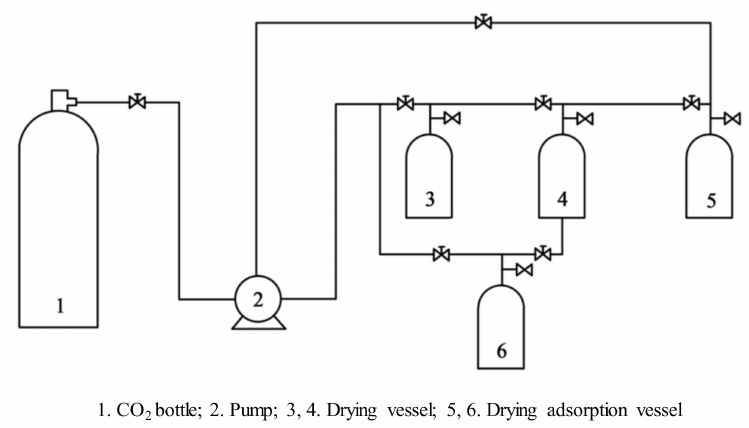
Figure 2. Supercritical CO 2 drying device.